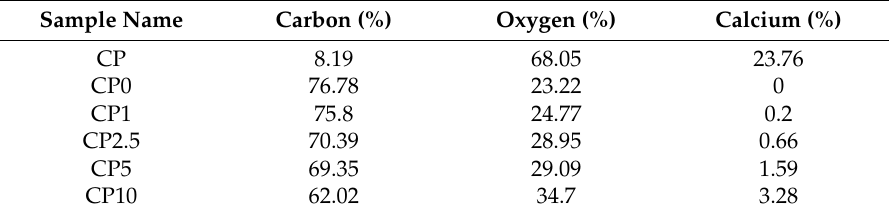
Table 2. Atomic percentage for each element in the samples identified by